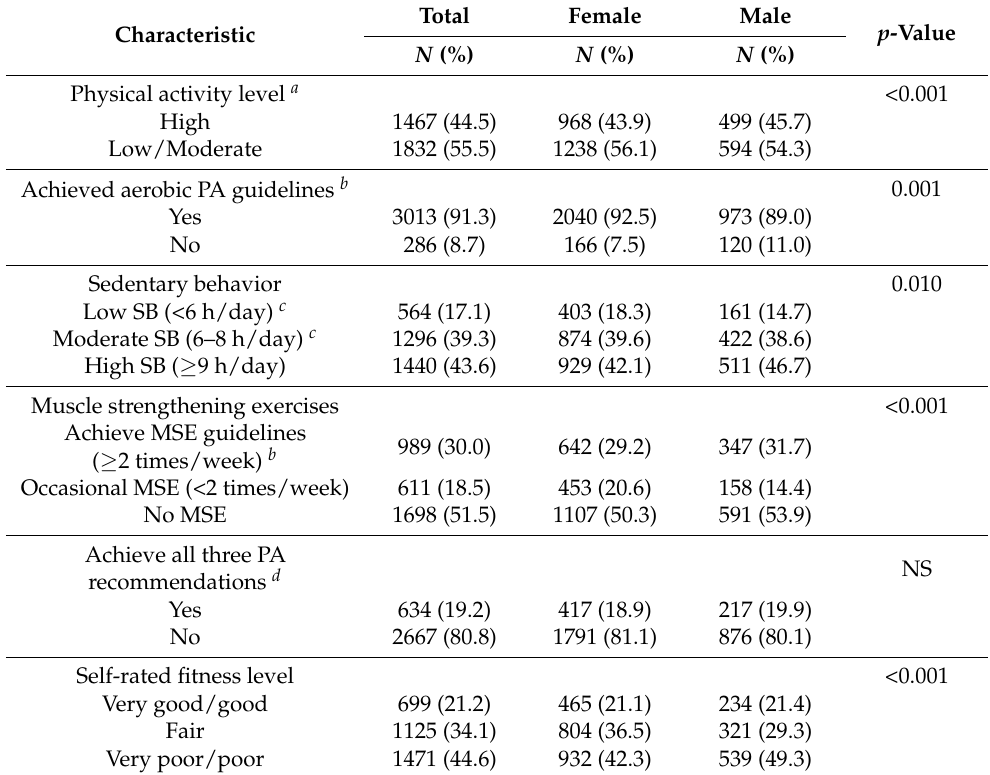
Table 2. Physical activity and fitness characteristics by